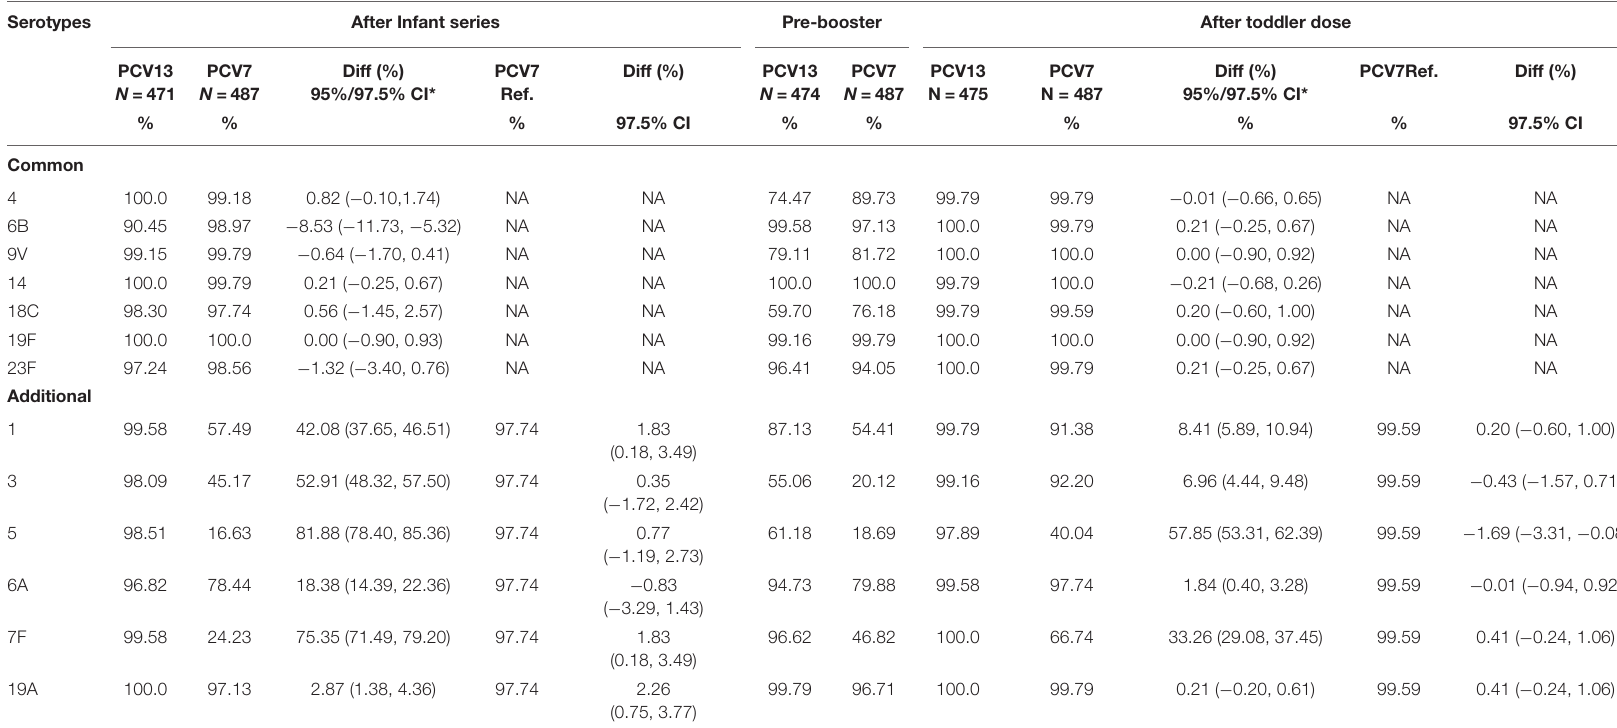
TABLE 3 | The proportion of subjects who reached a pneumococcal IgG antibody concentration ≥ 0.35 µ g/ml after receiving the infant series, pre-booster, and toddler doses. Serotypes After Infant series Pre-booster After toddler